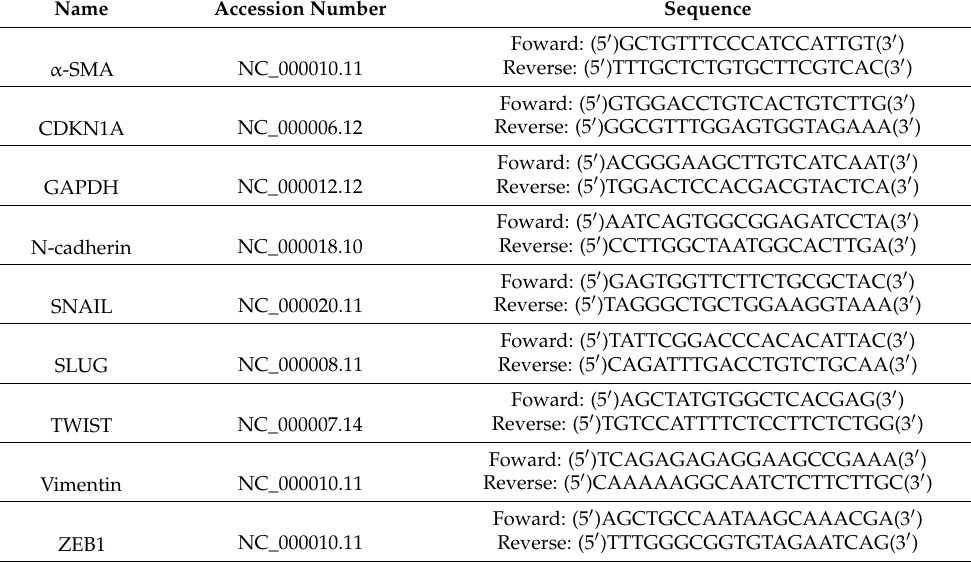
Table 1. Primer Sequences for real-time PCR